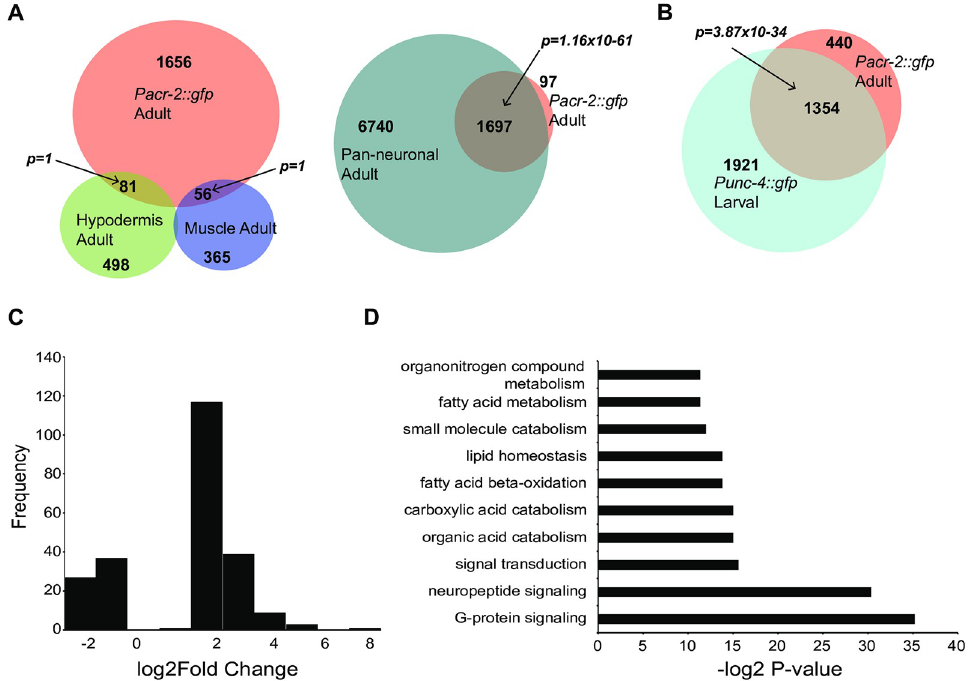
Fig 1. Differential expression analyses of acr-2(gf) neurons compared to wild type. A. Few genes identified as expressed in isolated adult neurons labeled by Pacr-2 :: gfp are enriched in hypodermal or muscle datasets [22]. In contrast, almost all of the genes identified as expressed in cholinergic neurons labeled by Pacr-2 :: gfp are identified in pan-neuronal data-sets. Shown are Venn Diagrams with overlaps between the indicated data sets. The number in each region indicates the number of genes in that category. Hypodermis, muscle, and neuronal datasets are from Kaletsky et al . (2018). Statistics for significance of overlap were performed using a hypergeometric distribution with the phyper function in R. B. Genes identified in previous expression profiling of larval cholinergic motoneurons, including core neuronal and cholinergic markers, are identified by RNA-seq of Pacr-2 :: gfp expressing neurons [23]. The Venn Diagram displays that over half of genes identified by microarray as expressed in larval A-type motoneurons are also identified by RNA-seq in adult cholinergic neurons that express P acr-2 :: gfp . The number in each region indicates the number of genes in that category. Larval A-type motor neuron expression data is from Von Stetina et al . (2007). Statistics for significance of overlap were performed using a hypergeometric distribution with the phyper function in R. C. Histogram of log 2 (Fold Change) for significantly different genes. Most genes that were different in acr-2(gf) compared to wild type were up- regulated at around 2-fold. D. GO-term analyses of genes significantly different in acr-2(gf) neurons compared to wild type (see Materials and methods). Genes involved in neuropeptide and G-protein signaling (which included neuropeptide genes) were the most affected.